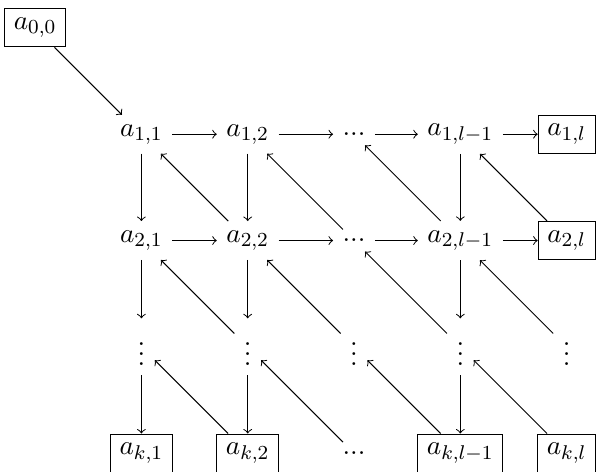
Figure 7. Initial seed for the G( k, n ) cluster algebra [48, 49], where l = n − k and a x,y denotes the Plücker coordinate h 1 , . . . , k − x, k + y − x +1 , . . . , k + y i . The arrows here are reversed (and the figure is transposed) with respect to that used in [22]; see the discussion in section